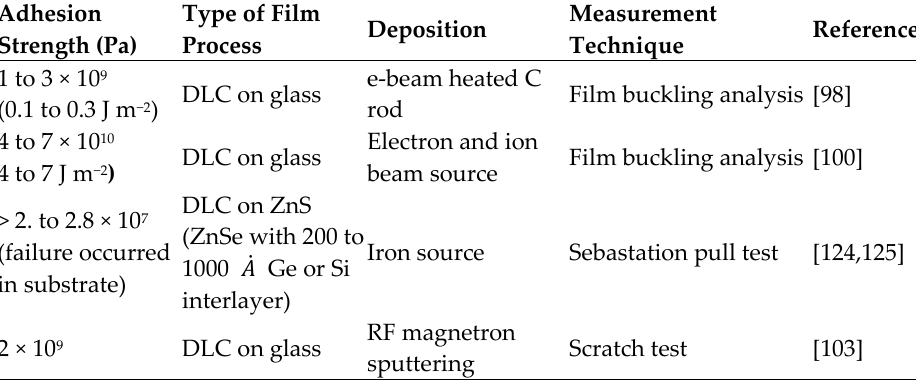
Table 5. Adhesion strength of various films and their fabrication